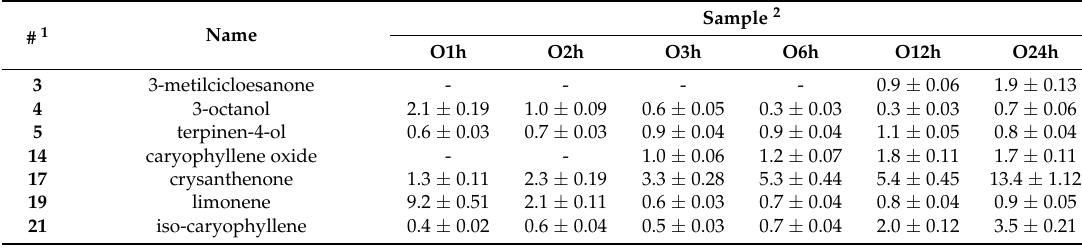
Table 5. Chemical composition (%) of TEOCG extracted in